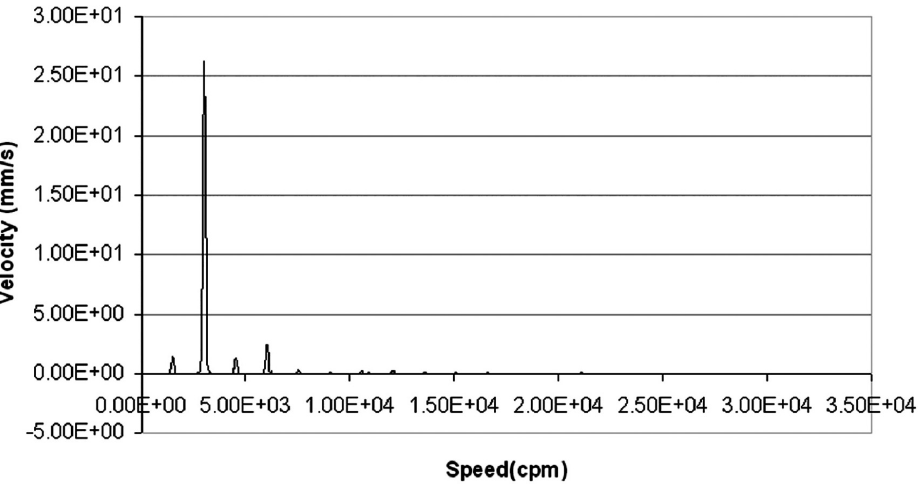
Fig. 6. Horizontal vibration spectrum of overall amplitude 23 mm/s.